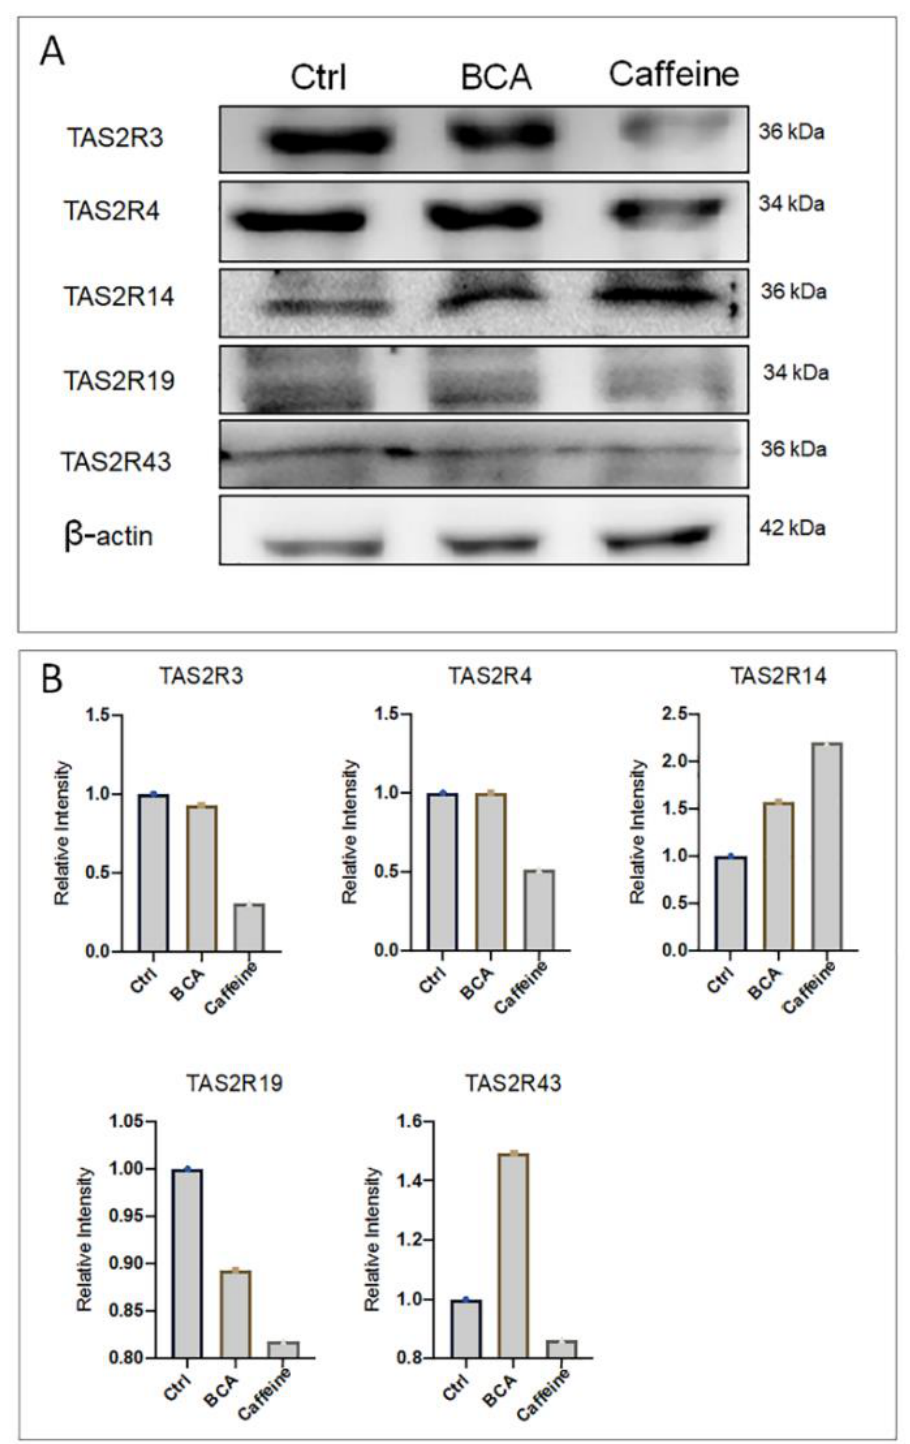
Figure 5. TAS2Rs protein expression in the hGL5 cell line. ( A ) Representative images of three independent western blot analysis of TAS2Rs after treatment with BCA and caffeine. β -actin was used as a loading control. ( B ) Relative quantification of western blotting band